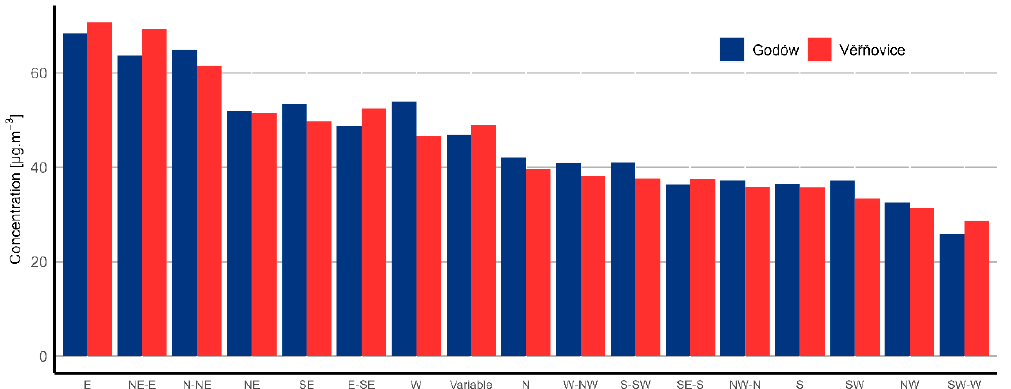
Figure 11. Average PM 10 concentrations for individual daily wind types, V ěřň ovice and Godów site,